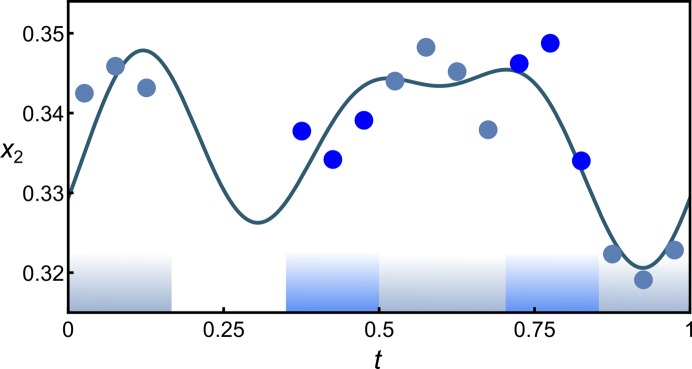

x
2 of T site of M40 #1 (PBE). Grey-blue corresponds to Al, dark blue to Si. Fitted modulation functions with first- to third-order harmonics are shown as a solid line. Approximate t sections at which the block wavefunctions of the occupational modulation of Al2 and Si2 are valued 1 are indicated at the bottom.